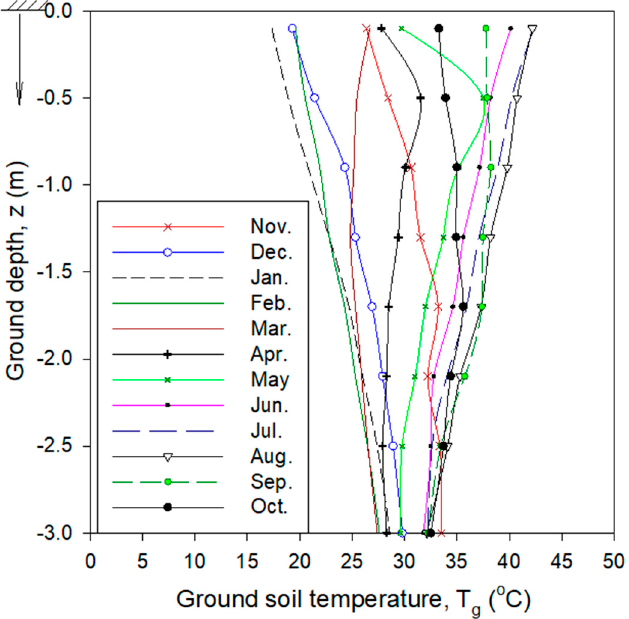
Figure 4. Vertical variation in the monthly average ground temperature ( T g ) at different depths ( z ) for Riyadh region, KSA, in the years 2020–2021.